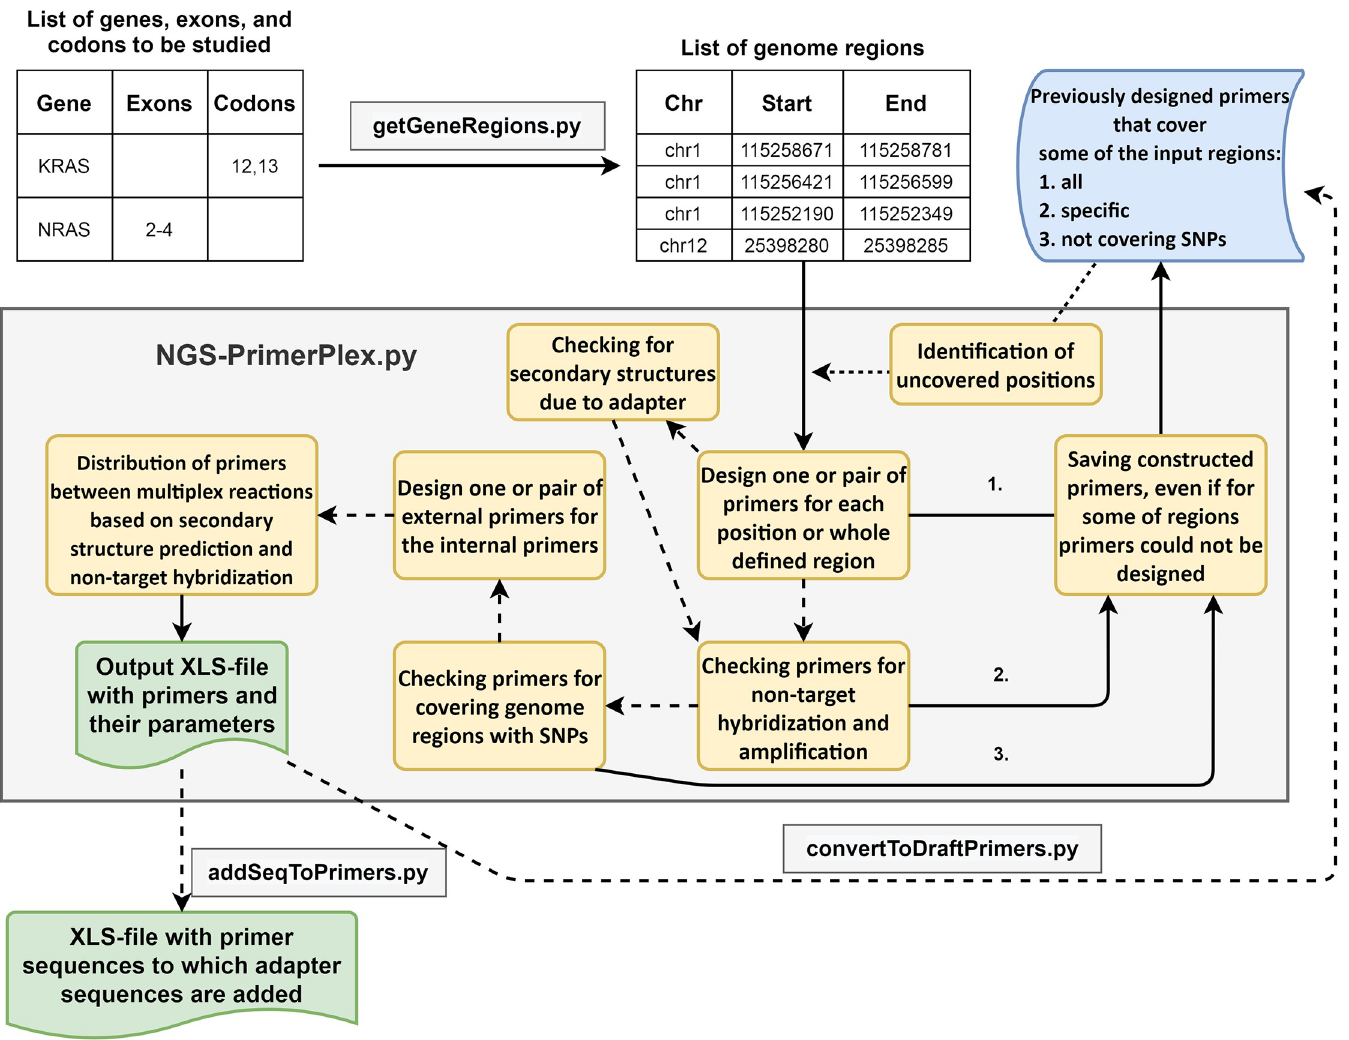
Fig 1. The whole workflow of the NGS-PrimerPlex. Solid arrows denote obligatory steps; dotted arrows denote optional steps that can be applied by the user. The primer design process starts from the list of sequence regions (e.g. regions of a reference genome), however, such region coordinates can be automatically obtained with getGeneRegions.py script. NGS-PrimerPlex tries to design primers for all input regions saving primers constructed to the XLS-file (“draft” file 1). If it is necessary, all primers are verified for the forming secondary structures due to the additional adapter sequences at the 5’-ends of primers. If all target regions are covered, the primers are verified for non-target hybridization and amplification. Primers that do not hybridize to many targets and do not form non-target amplicons are saved to distinct XLS-file (“draft” file 2), others are removed. If all target regions are still covered, the primers are verified for overlapping genome regions with variable positions. Primers that do not overlap variable positions with defined parameters (the frequency of the alternative allele and the distance to the 3’-end) are saved to the new XLS-file (“draft” file 3), others are removed. If all targets are still covered, primers are distributed to the defined number of pools. The diagram was drawn in https://app.diagrams.net.